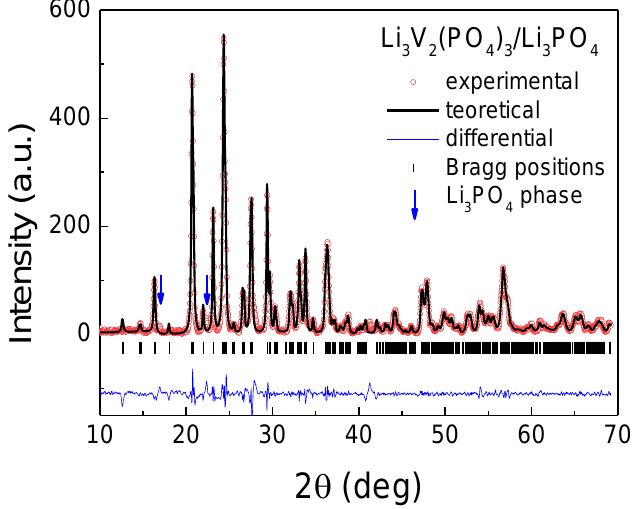
Figure 1. Experimental, theoretical, and differential diffraction patterns of the Li 3 V 2 (PO 4 ) 3 /Li 3 PO 4 composite.